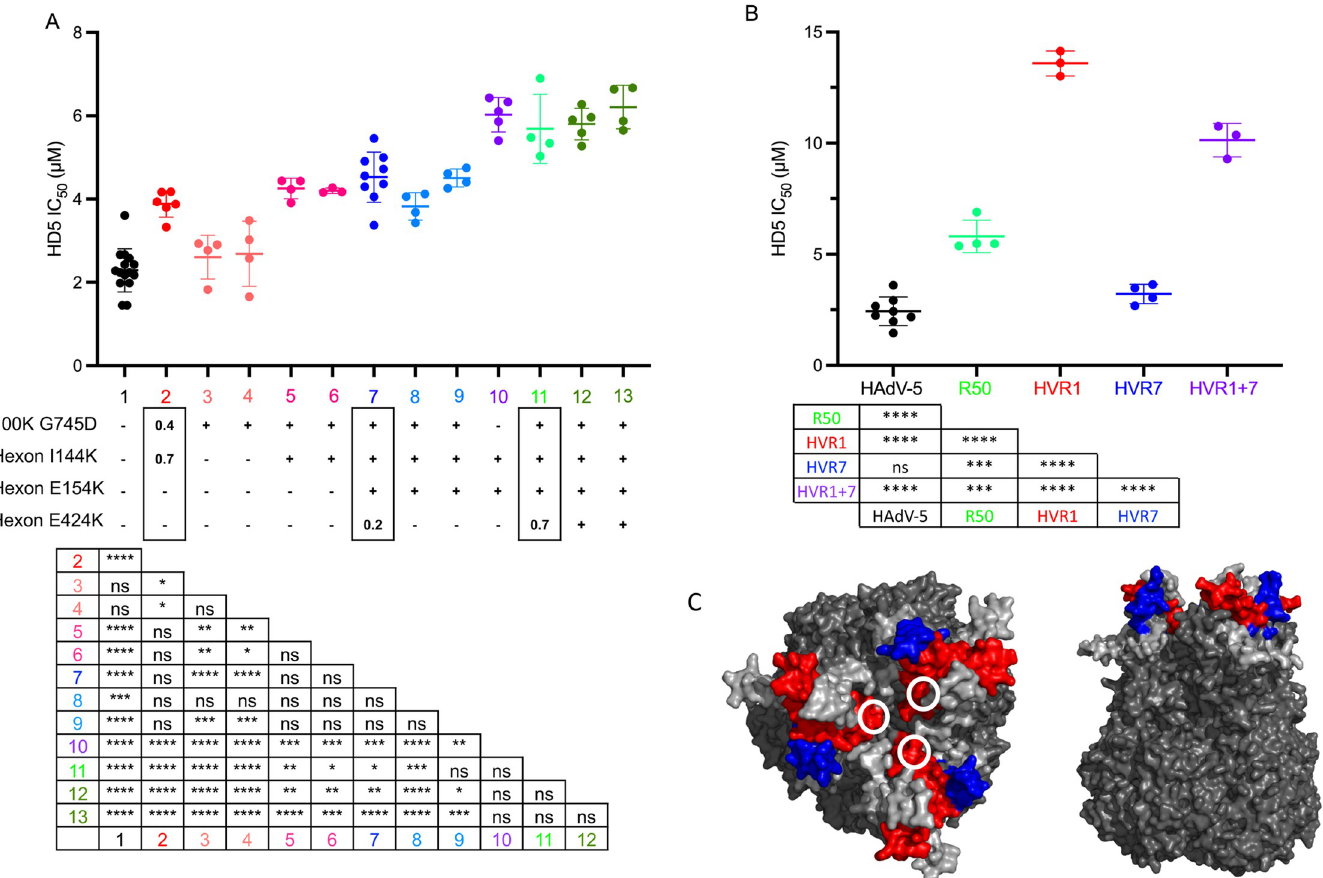
Fig 2. Hexon HVR1 is a determinant of HD5-mediated neutralization. (A) The HD5 IC 50 s of HAdV-5 “mutator” virus (column 1, black); pools of virus expanded from rounds 10 (column 2, red), 40 (column 7, dark blue), and 50 (column 11, light green); plaque purified viruses from rounds 10 (columns 3–4, salmon; columns 5–6, pinks), 40 (columns 8 and 9, blues), and 50 (columns 12 and 13, greens) of the selection; and an engineered virus containing only the indicated hexon mutations (column 10, purple) were determined on 293 β 5 cells. The presence of each hexon and L4-100K mutation is denoted below the graph. For the pooled viruses, the fraction of reads containing each mutation is indicated within the rectangles. Each point is an independent experiment, and bars are the mean ± SD. The results of one-way ANOVA with Tukey’s multiple comparison test are indicated by asterisks below. (B) The HD5 IC 50 s of the indicated viruses were determined on A549 cells. Each point is an independent experiment, and bars are the mean ± SD. Virus expanded from the 50 th round of selection (R50) is equivalent to sample 11 in panel A. Results of one- way ANOVA with Tukey’s multiple comparisons test are shown by asterisks below. (C) Space-filling model of the structure of a HAdV-5 hexon trimer (PDBID:6CGV [44]) from top and side views. HVR1 (blue) is modeled using the structure of the shorter HVR1 from species D HAdV-26 (PDBID:5TX1 [45]). White circles indicate the position of E424 in HVR7 (red). All other HVRs are light